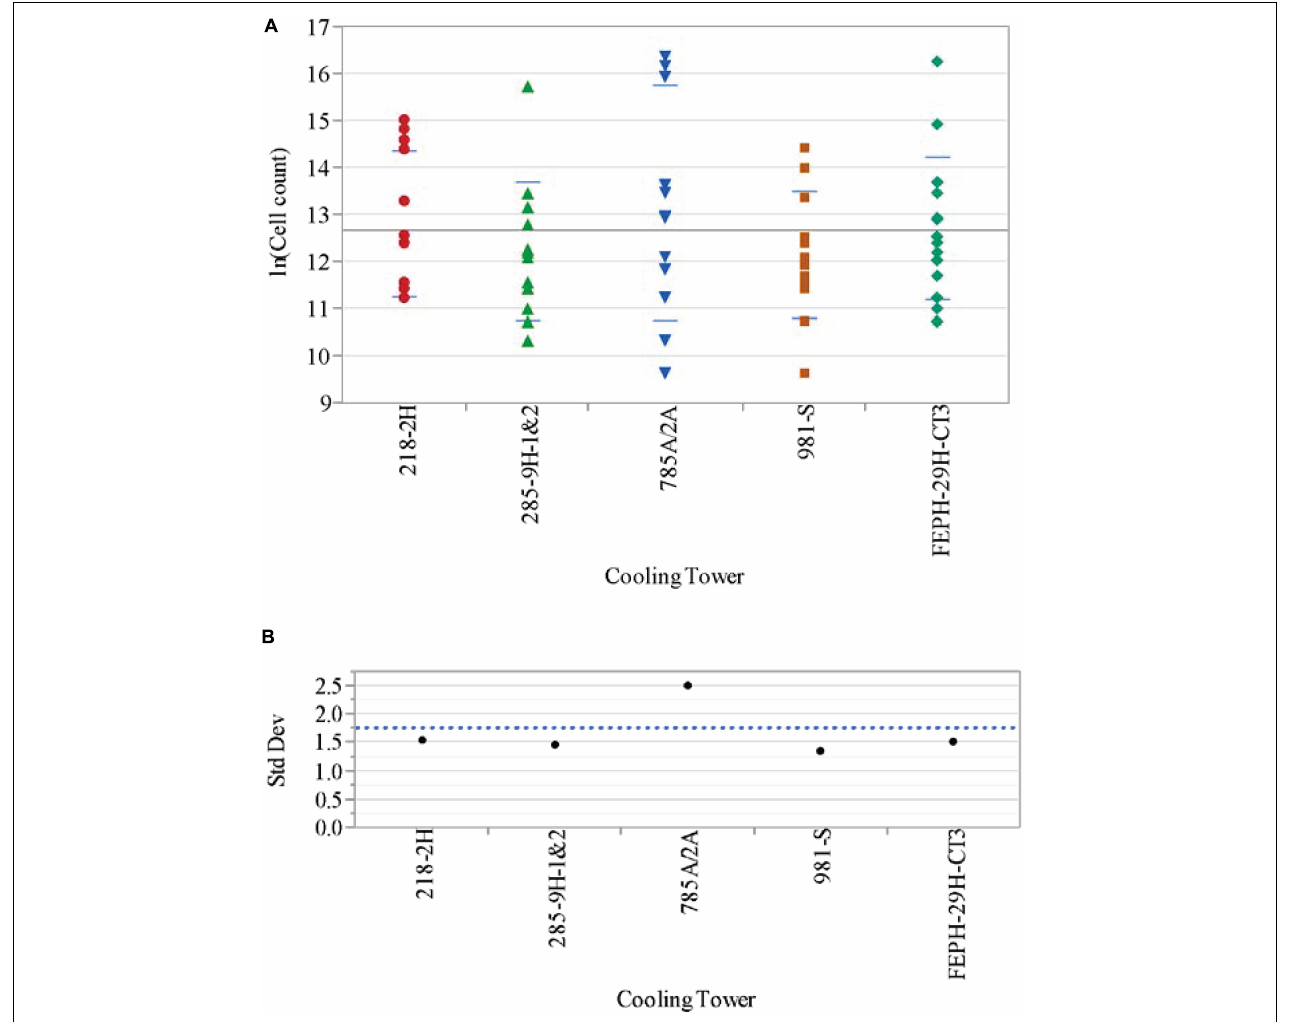
FIGURE 3 | (A) Analysis of Legionella pneumophila concentrations ln(Cell count) by cooling tower. (B) Variance of Legionella pneumophila concentrations ln (cell count) by cooling